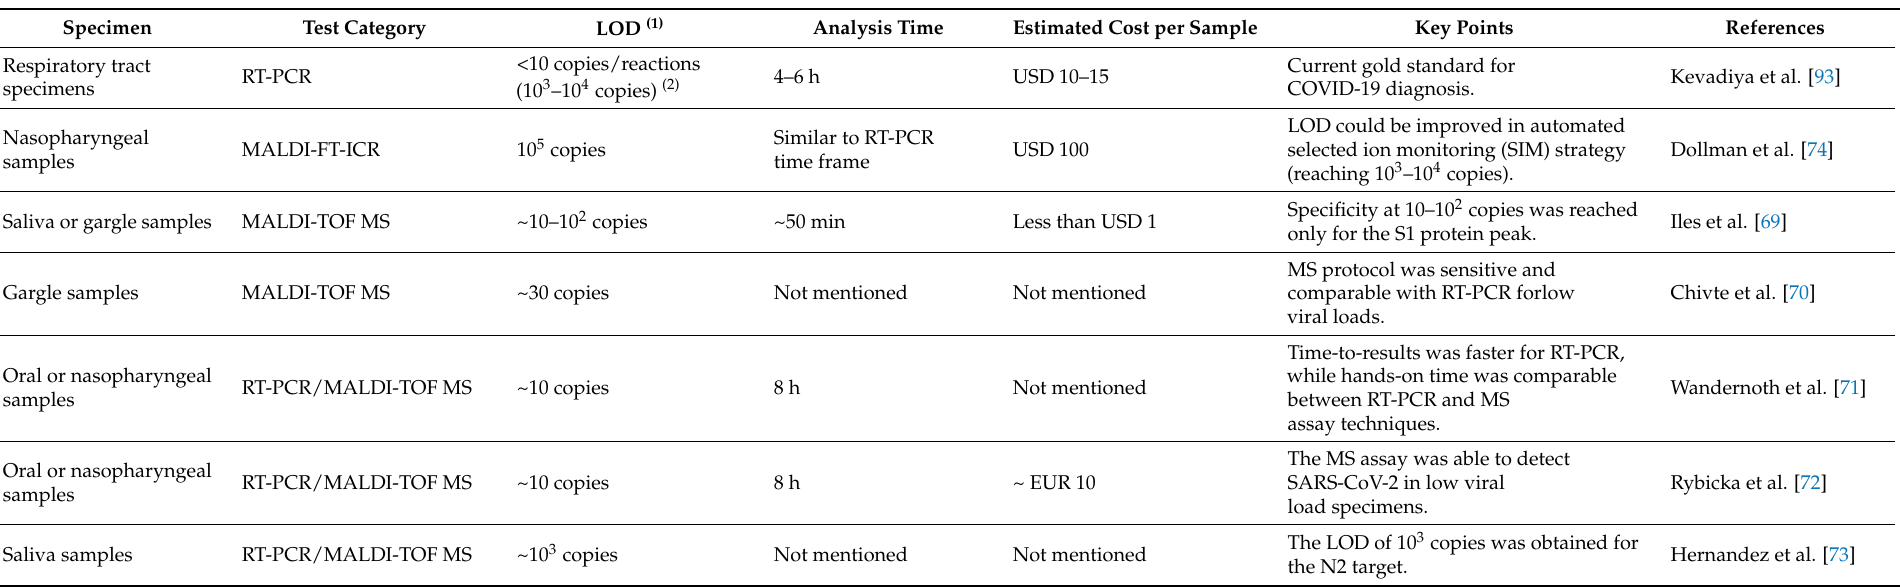
Table 2. Diagnostic performances and estimated costs of the different tests used for SARS-CoV-2